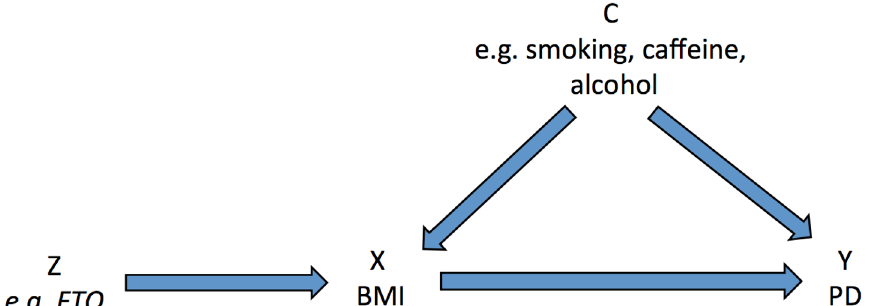
Fig 1. Directedacyclic graph of instrumental variable analysis using genetic variants as proxies for environmental exposures (adapted from Lawlor et al. [14]). Genetic variants ( Z ) associated with an exposuresuch as BMI ( X ) can be used as proxiesto determine the effect of the exposure( X ) on the outcome ( Y ). The three IV assumptions are indicatedby arrows or the absenceof arrows: (1) the IV in this schematic ( FTO gene variant) is robustly associatedwith the exposure; (2) the IV is not associatedwith confounding factors ( C ); and (3) there is no alternativeway that the IV affects the outcome other than via the exposure. BMI, body mass index; IV, instrumental variable; PD, Parkinson